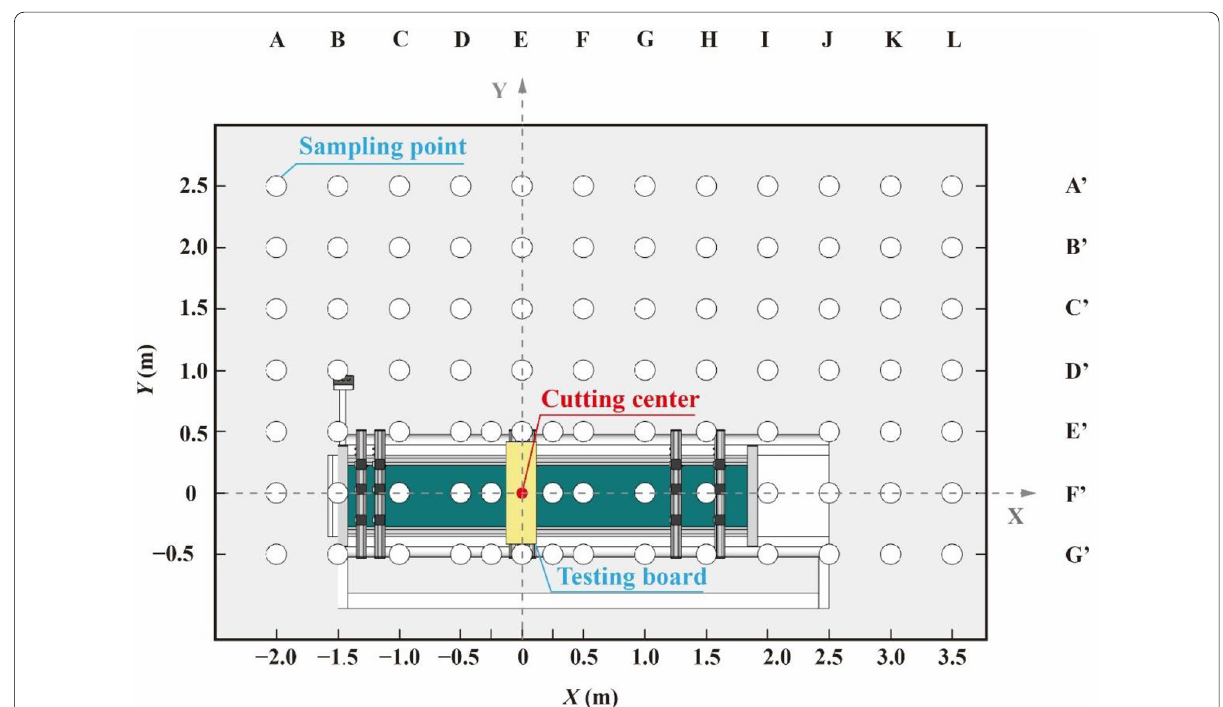
Fig. 2 Top view of workshop of MDF milling and layout of sampling points